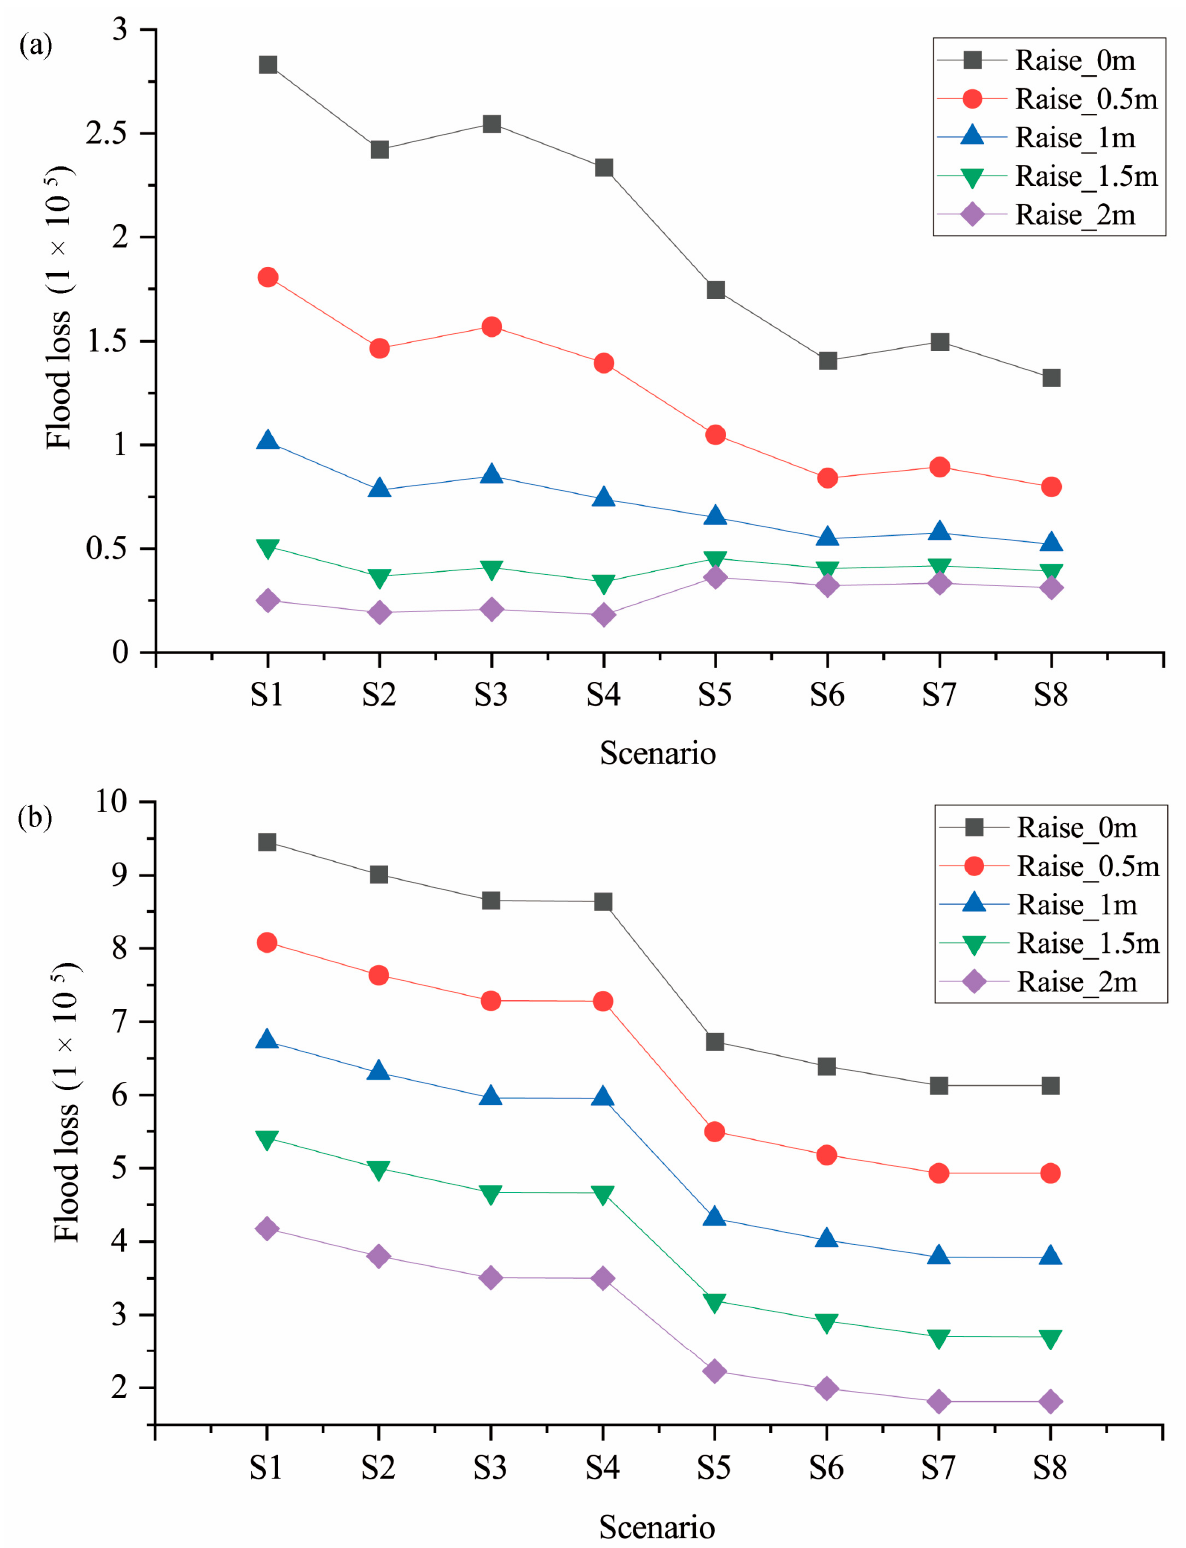
Figure 16. Flood loss under different scenarios when elevating structures’ bases in RT I ( a ) and RT II ( b ).